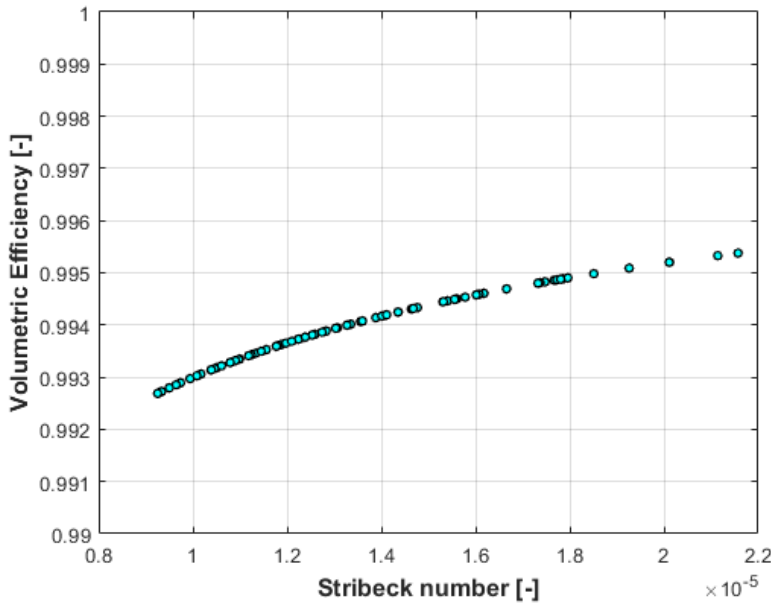
Figure 12. Volumetric efficiency of the oil pump for all experimental data points.